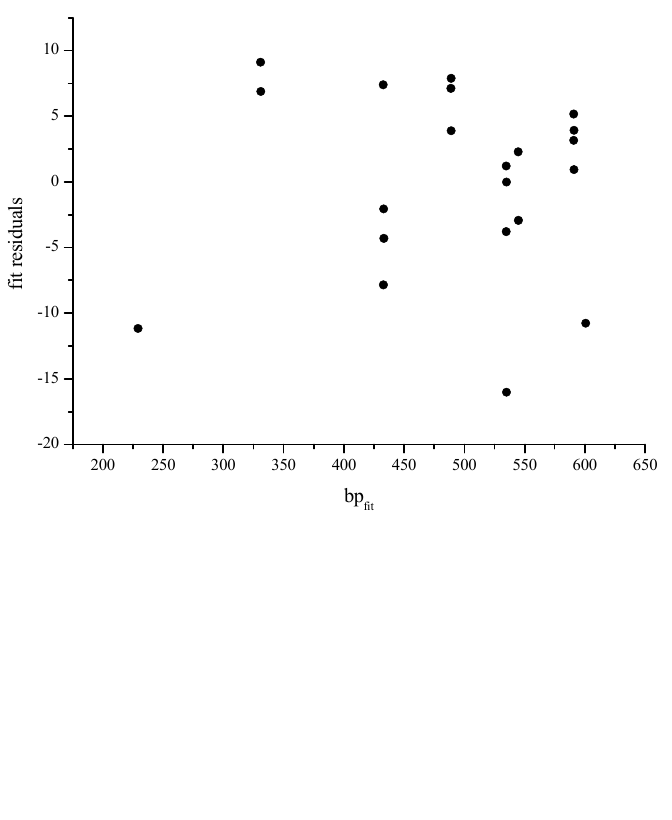
) and of cross validated fit ), cv